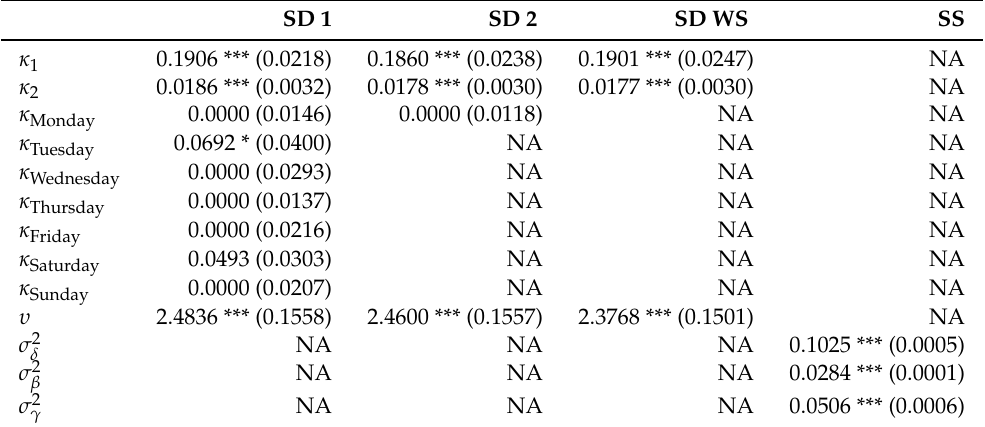
Table A8. Parameter estimates for Jamaica.